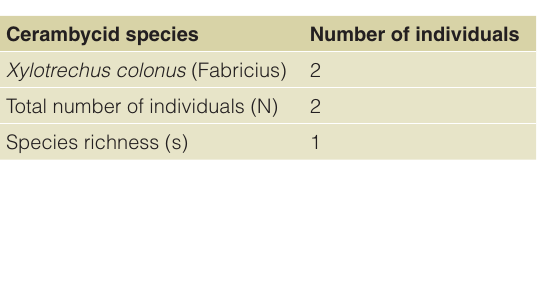
Table 5. Cerambycid (Coleoptera: Cerambycidae) Species Captured in Bradner Preserve, 2008 (Western Wood County, OH). Total number of individuals of each species caught during the entire trapping period (early June to early October). Traps were positioned in the approximate center of each forest and all checked each